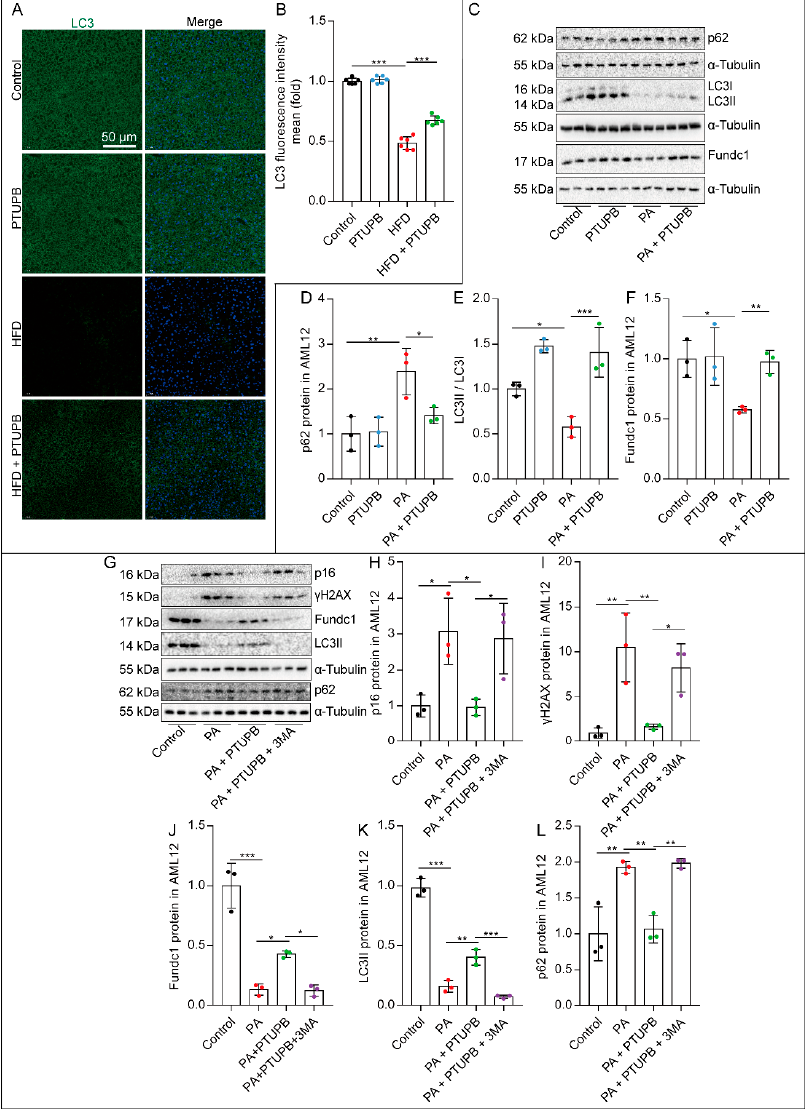
Figure 5. PTUPB attenuates hepatocyte senescence by enhancing autophagy in AML12 cells. The fluorescence intensity of liver LC3 was detected by immunofluorescence (( A ), scale bars = 50 μ m, n = 6). Image J was used to analyze the fluorescence intensity of LC3 (( B ), n = 6). Cells were treated with PTUPB (1 μ M) for 1 h before treatment with PA (200 μ M). The protein expressions of p62, LC3I/II, and Fundc1 were measured by Western blot and quantitatively analyzed in AML12 cells treated with PA for 48 h (( C – F ), n = 3). Cells were treated with PTUPB (1 μ M) and 3-MA (5 mM) for 1 h before treatment with PA (200 μ M). The protein expressions of p16, γ H2AX, Fundc1, LC3II, and p62 were measured by Western blot and quantitatively analyzed in AML12 cells (( G – L ), n = 3). Data are expressed as the mean ± SD. Differences among multiple groups were performed using ANOVA. Tukey’s test was used as a post hoc test for pairwise comparisons. * p < 0.05, ** p < 0.01, and *** p <